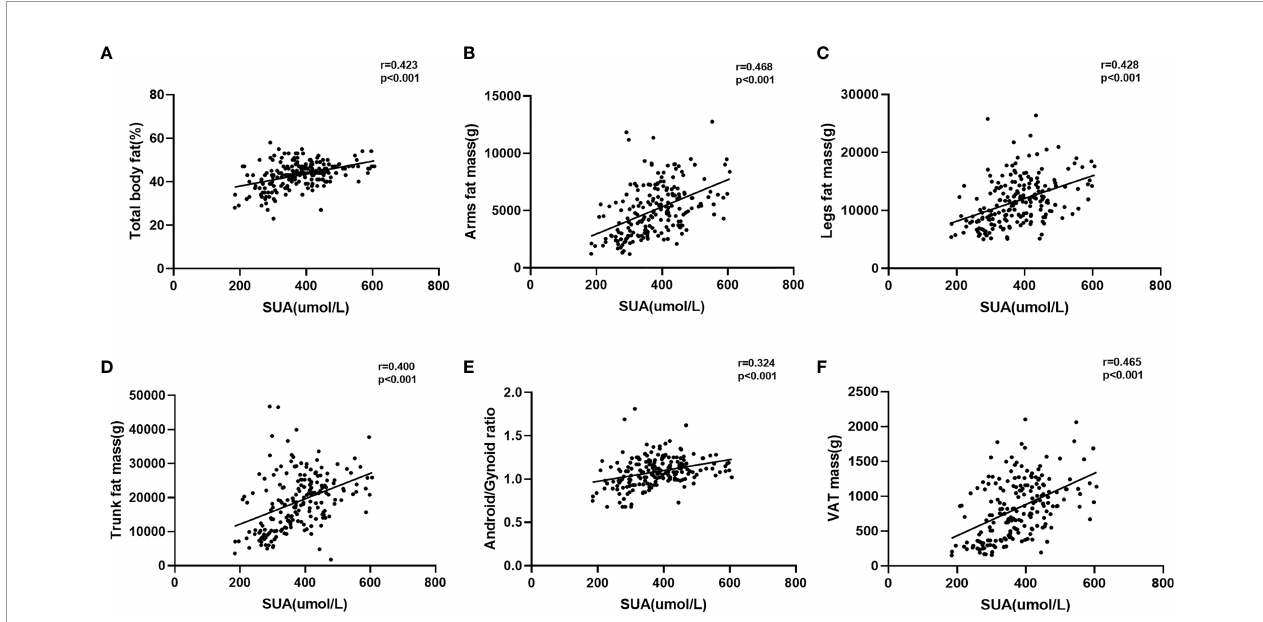
FIGURE 2 | Correlation between serum uric acid and body fat distribution. (A) Correlation between serum uric acid and total body fat%; (B) correlation between serum uric acid and arm fat mass; (C) correlation between serum uric acid and leg fat mass; (D) correlation between serum uric acid and trunk fat mass; (E) correlation between serum uric acid and android/gynoid ratio; (F) correlation between serum uric acid and VAT